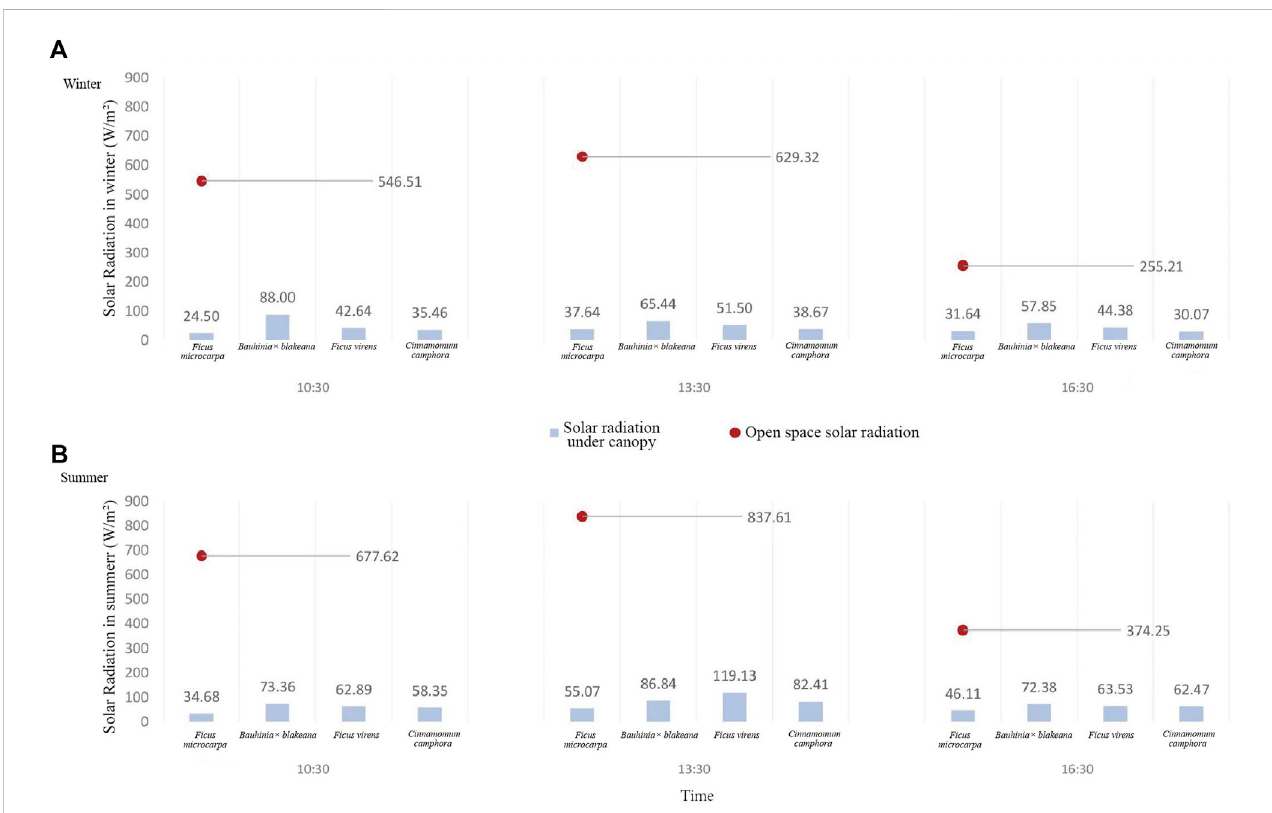
Solar radiation underneath the canopy of the four tree species in winter (A) and summer (B)